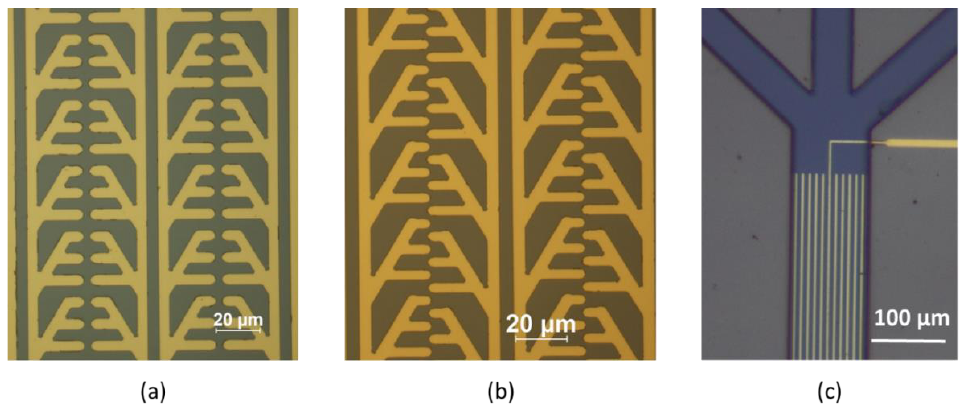
Figure 4. Close up of the chip. ( a ) Face-to-face electrode design. ( b ) Zig-zag electrode design. ( c ) DC chip design.